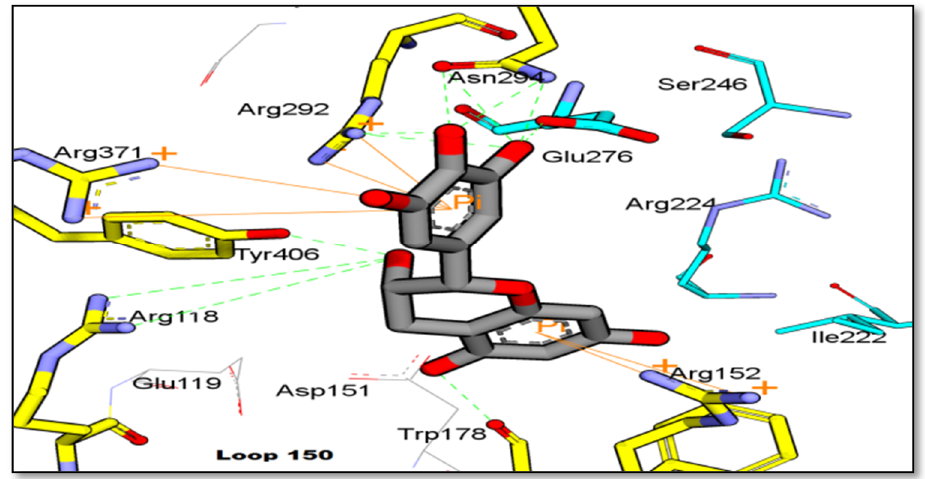
Figure 7. Binding interaction of GC4 from GCL against H 1 N 1 -NA (PDB code: 3B7E). (Blue carbon: hydrophobic residues).